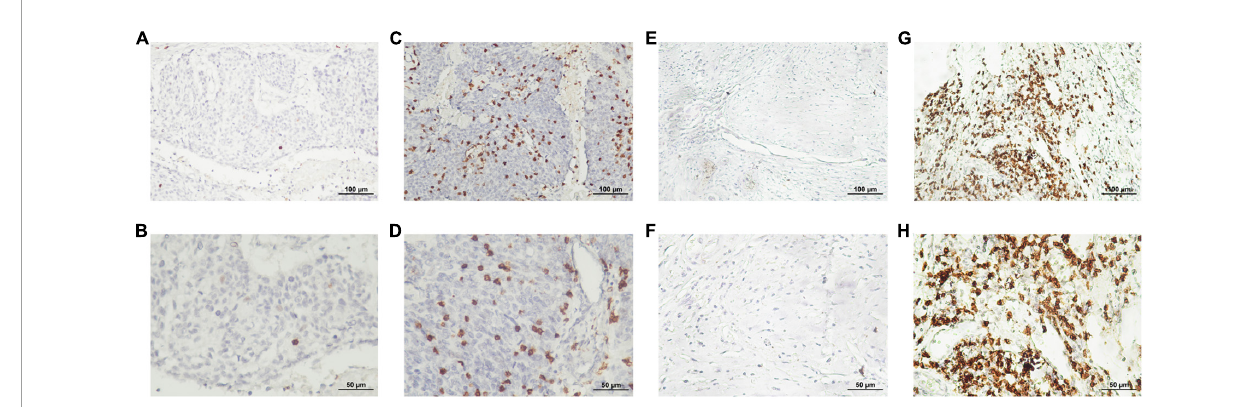
FIGURE3 Representative photomicrographs of immunohistochemical staining for CD8 + cytotoxic T cells. (A–D) Low and high intratumoral infiltration of CD8 + cytotoxic T cells, respectively. (E–H) Low and high peritumoral infiltration of CD8 + cytotoxic T cells, respectively (upper panels, × 200 magnification; lower panels, × 400 magnification).